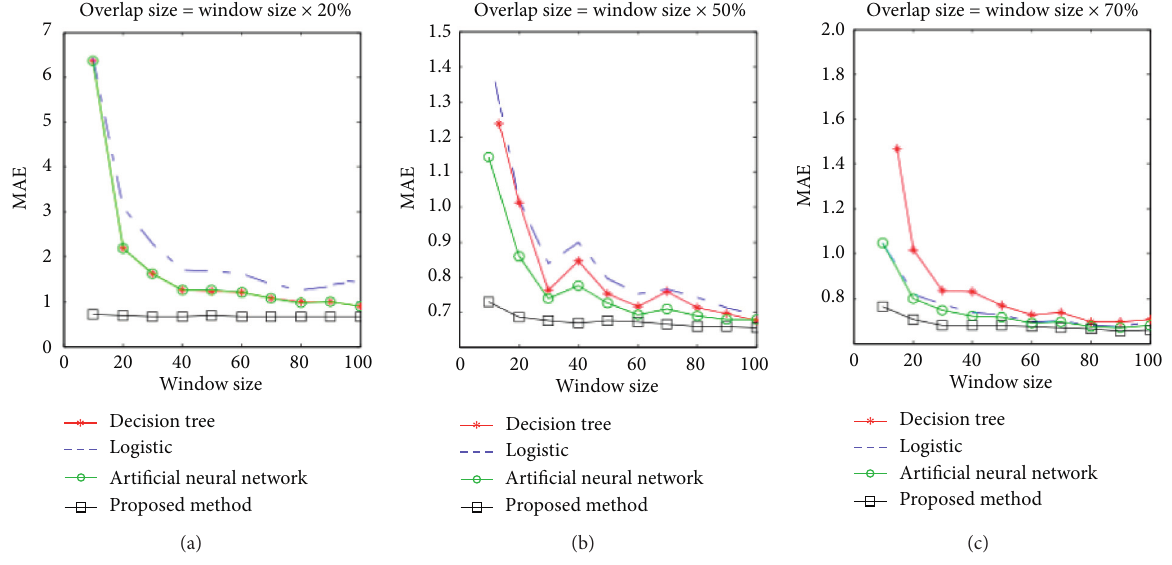
Figure 7: Detection performance of each classifier under different overlapping window sizes units: minutes.